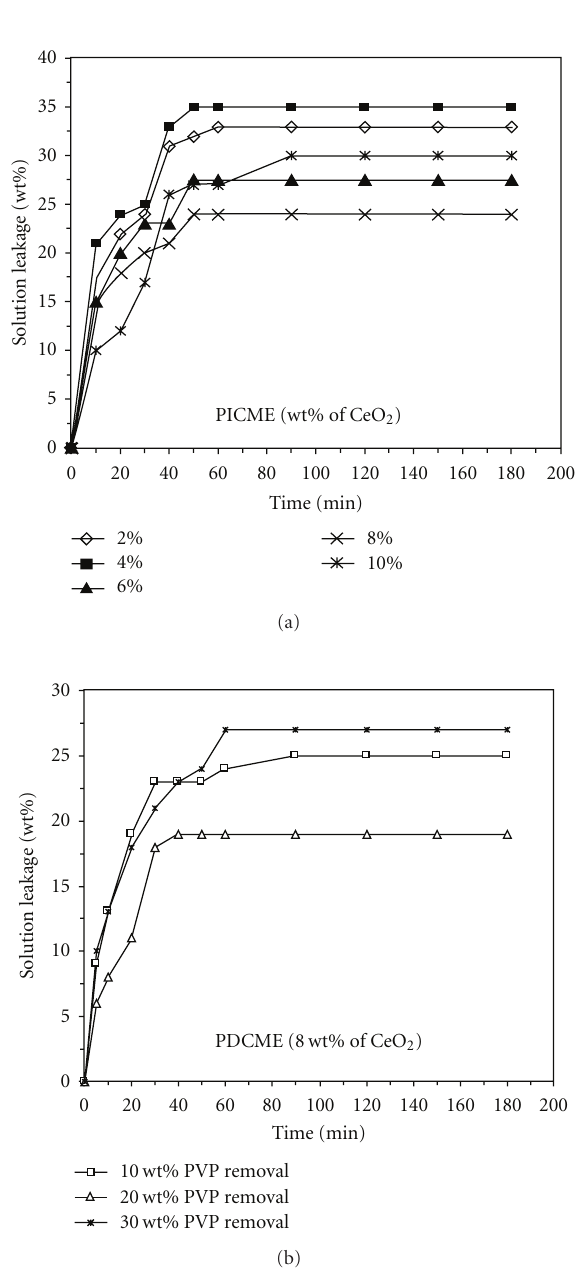
Figure 2: Solution leakage versus time of the polymer electrolyte (a) PICMs (b)